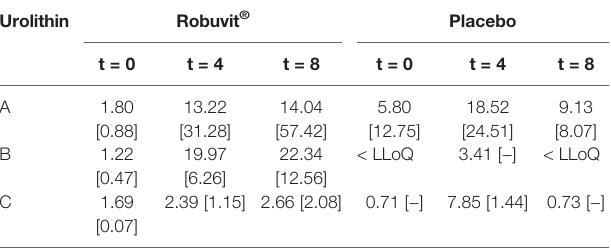
FIGURE 2 | Box-plot of the analytes detected in the patients' serum samples after 8 weeks of daily intake of 300 mg Robuvit ® . Due to the high inter-individual variability of polyphenol concentrations, the y-axis is in a logarithmical TABLE 2 | Concentration of urolithins in serum (ng/ml) of the participating patients before the intervention (t = 0), and after 4 and 8 weeks intake of Robuvit ® or placebo (t = 4 and t = 8).